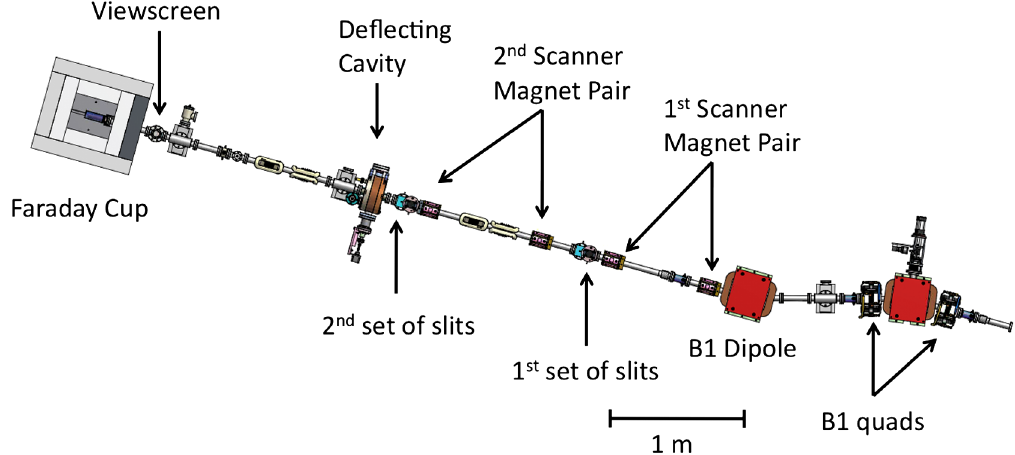
FIG. 2. Top view of the B1 injector merger section showing the emittance measurement system.